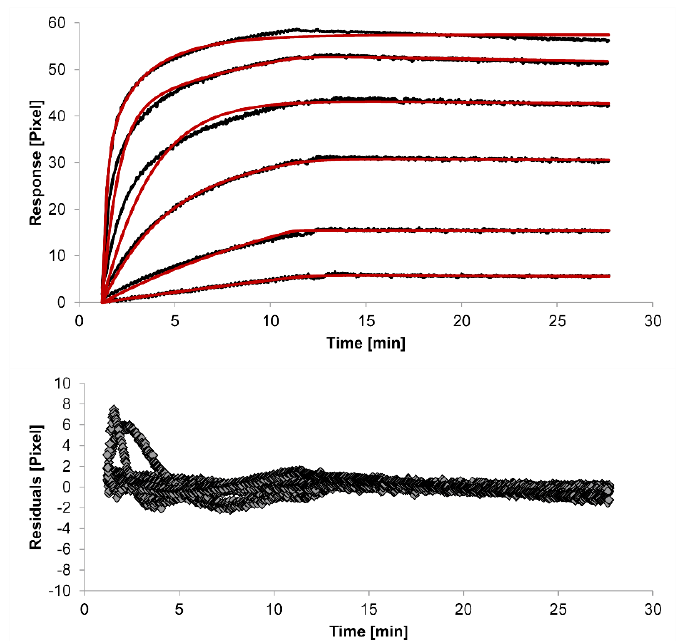
Figure 4. Kinetics of HSA-specific antibodies binding to immobilized HSA. Plots generated by applying the bivalent analyte model (red lines) overlay the plots associated with each antibody concentration (black lines; from top to bottom: 3.4 µM, 0.9 µM, 0.2 µM, 53.9 nM, 13.5 nM, 3.4 nM). Values resulting from the average of two sensing spots and the subtraction of reference surface signals from raw signal measurements are presented on the